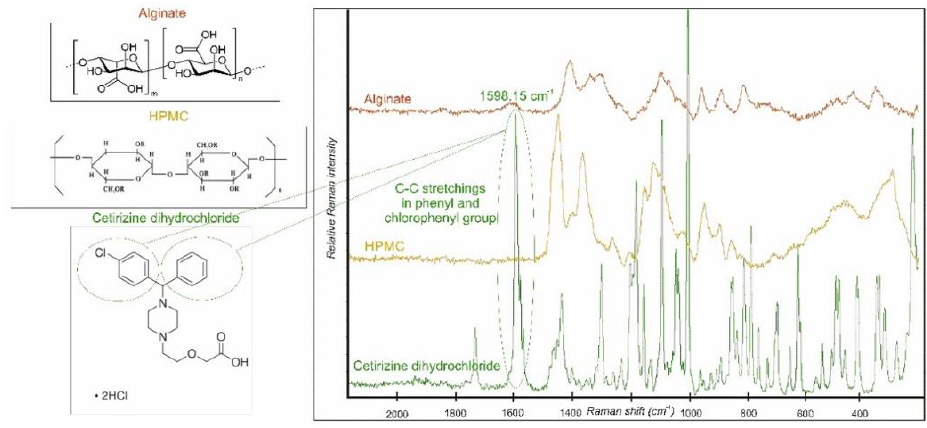
Figure 4. Individual Raman spectra of SA, HPMC, and CTZ.